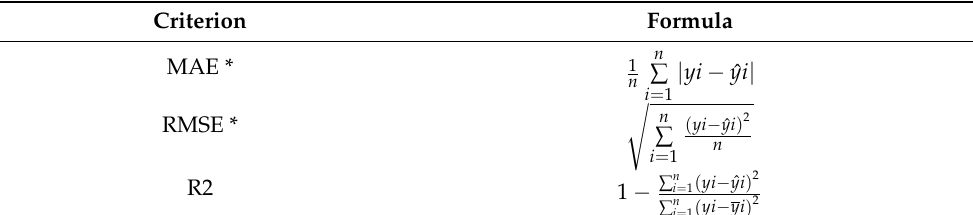
Table 5. Model comparison criteria.